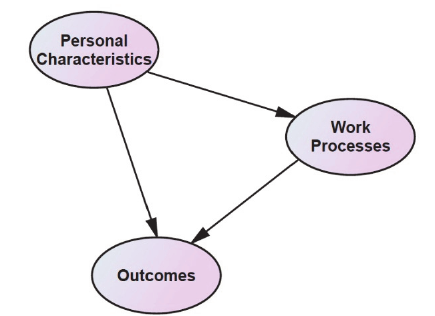
Fig. 7. Dependence among factors